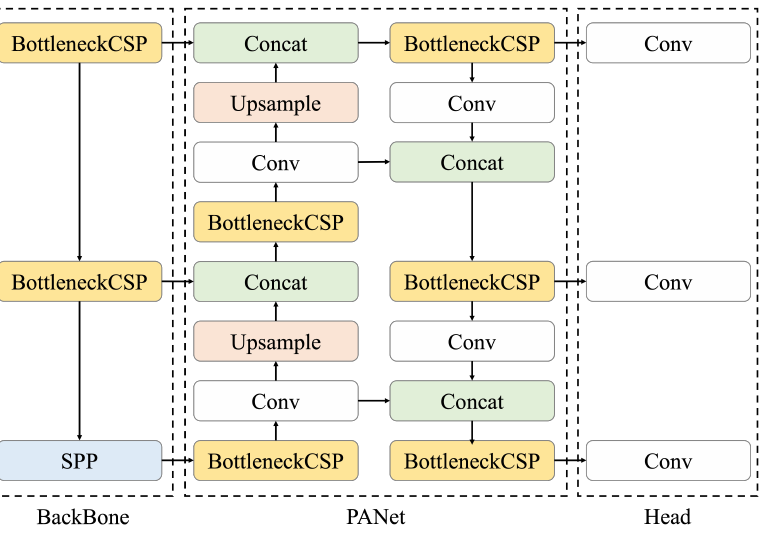
Figure 3. Architecture of YOLOv5, consisting of three components: BackBone, PANet, and Head. BottleNeck CSP refers to CSP Bottleneck, SPP to Spatial Pyramid Pooling, Conv to the Convolutional Layer, and Concat to the Concatenate Function. First, feature extraction is performed on multiple scales using BackBone, then PANet processes the extracted feature map, and finally Head outputs the class, score, position, and size as detection